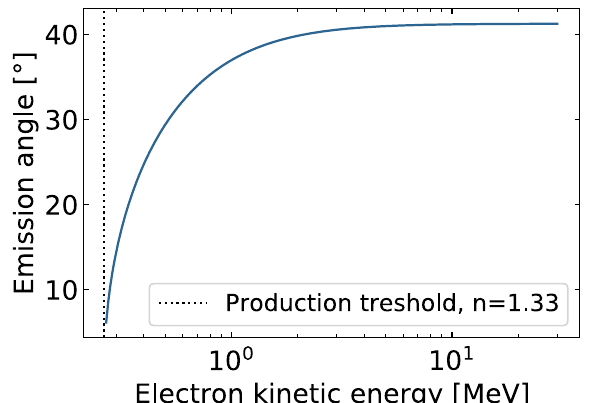
Figure 7. Cherenkov signal emission angle as function of a charged particle kinetic energy, an electron in that case, in water ( n = 1.33 ).